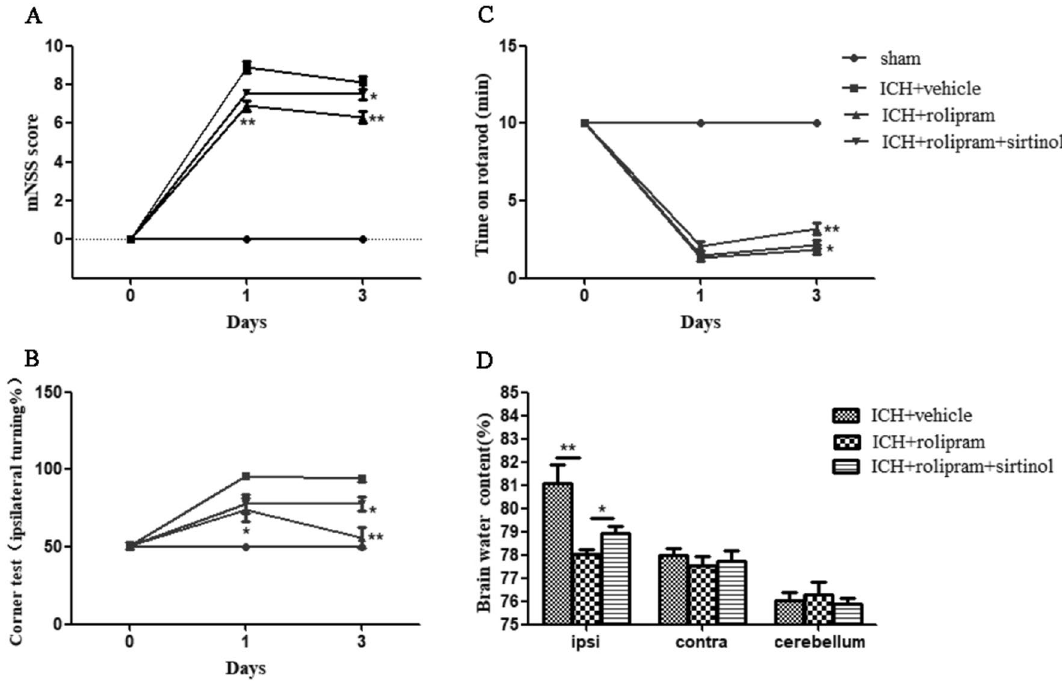
Figure 2. Rolipram ameliorated ICH-related motor deficits and reduced brain water content. ( A – C ) Behavioural performance was measured with mNSS, corner turning and time on the rotarod on day 1 and day 3 after ICH. The two-way ANOVA was applied for behavioral test. ( D ) Brain water content on day 3 after ICH. The Mann–Whitney U test was used to compare differences between groups in brain water content test. The data are presented as the means ± SEM. * p < 0.05, ** p <